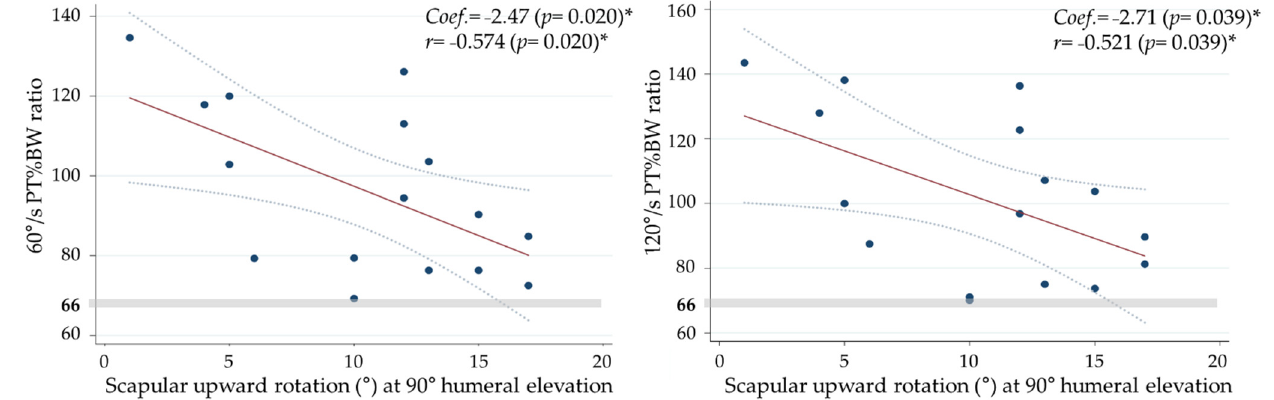
Figure 3. The relationship between scapular upward rotation (°) at 90° humeral elevation and ER/IR (PT%BW) ratio of 60°/s and 120°/s. (* p < 0.05)